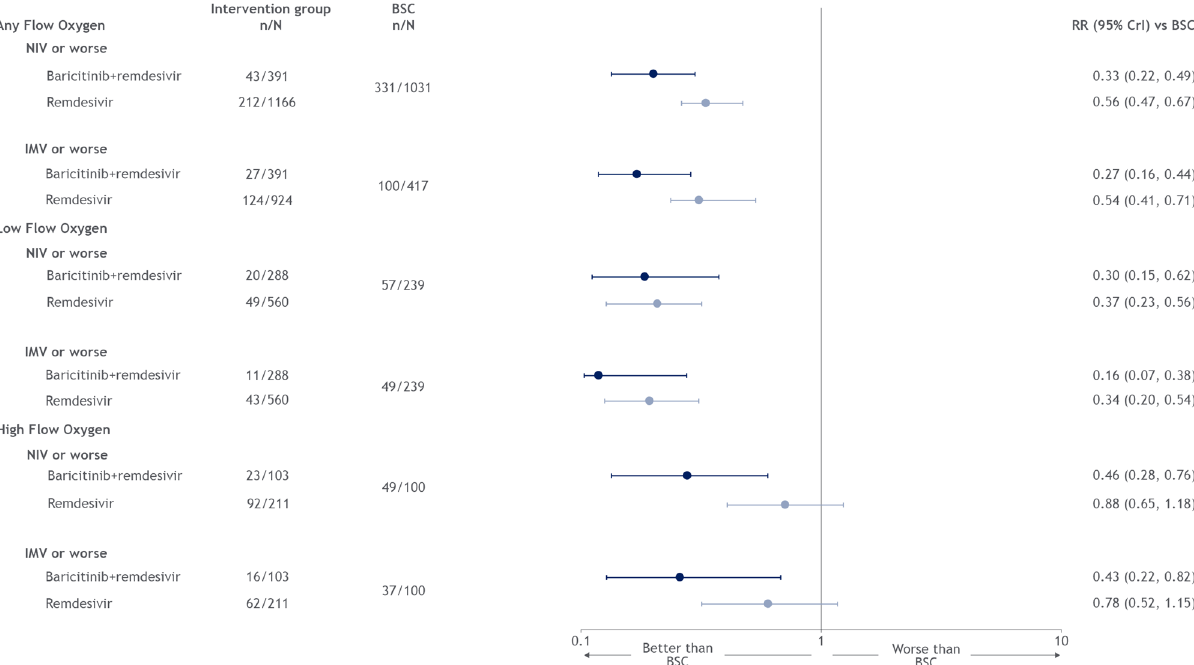
Figure 5. Forest plot for need for non-invasive ventilation or invasive medical ventilation support endpoint, by type of non-invasive oxygen